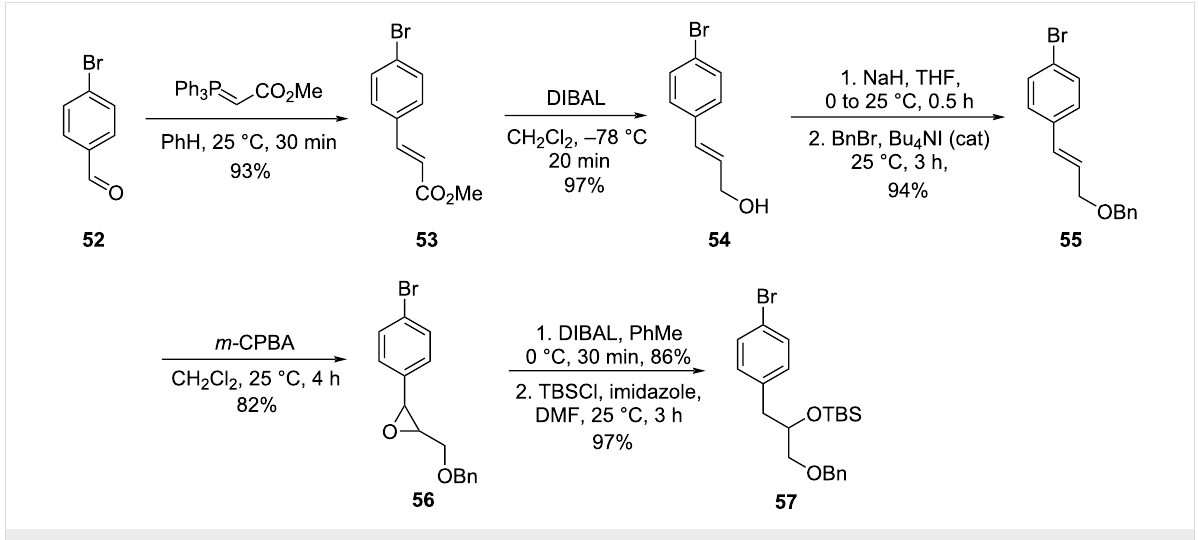
Scheme 10: Synthesis of fragment 57 by Couladouros and co-workers